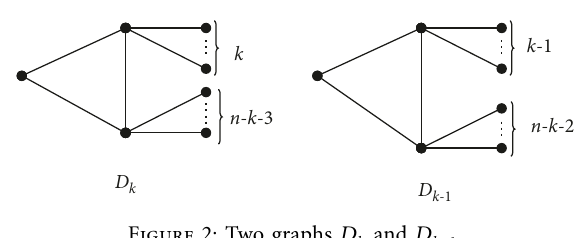
Figure 2: Two graphs D